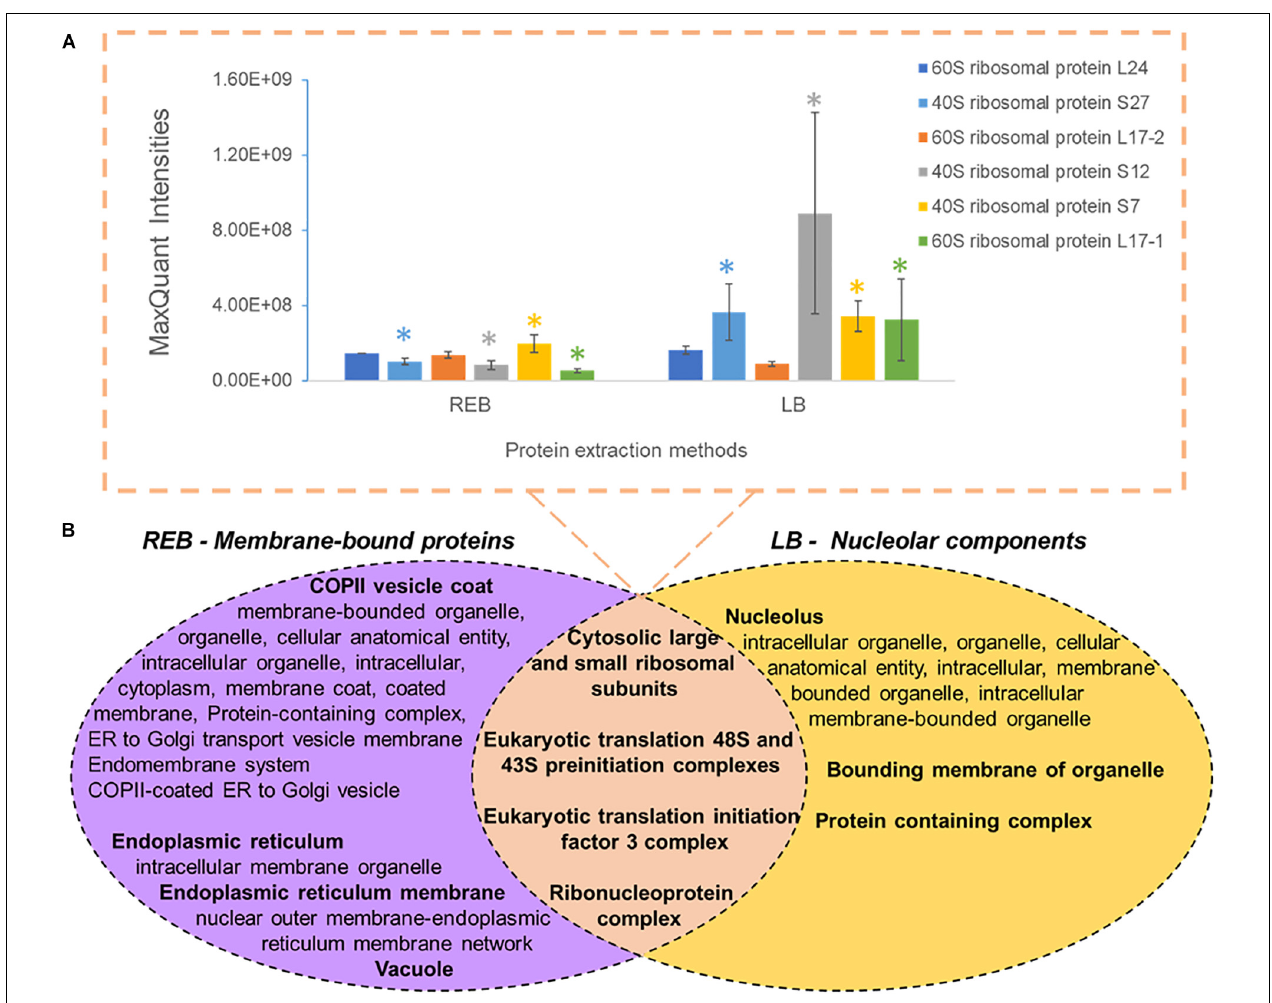
FIGURE 2 | Comparison of unique and shared obtained barley proteome using two extraction methods (see also Supplementary Figure 2 and Supplementary Table 2 ), namely, a soft membrane solubilization using mild detergents [ribosome extraction buffer (REB)] and a hard membrane disruption using SDS [lysis buffer (LB)]. (A) Recovered Swiss-Prot Hordeum vulgare ribosomal proteins that were prioritized to control for the efficiency of different extraction methods ( n = 3, error bars signal the standard deviation). Significance was determined per individual protein using a two-independent-samples t -test and is signaled by a colored star (*) when the P value was < 0.05. (B) Comparison of different extraction methods sampling partially redundant and unique proteome fractions. Bold indicates the parent gene ontology (GO) term to the subsequent enriched cellular components according to a hierarchical sorting (Carbon et al., 2009; Mi et al., 2019). The enriched terms are interpreted as a group rather than individually. In the intersect, only translation-related GO parent terms are depicted; for the full categories, see Supplementary Table 2 . Note that by combining both extractions, our methodology enriches membrane-bound mature ribosomes and pre-ribosomal particles present in the